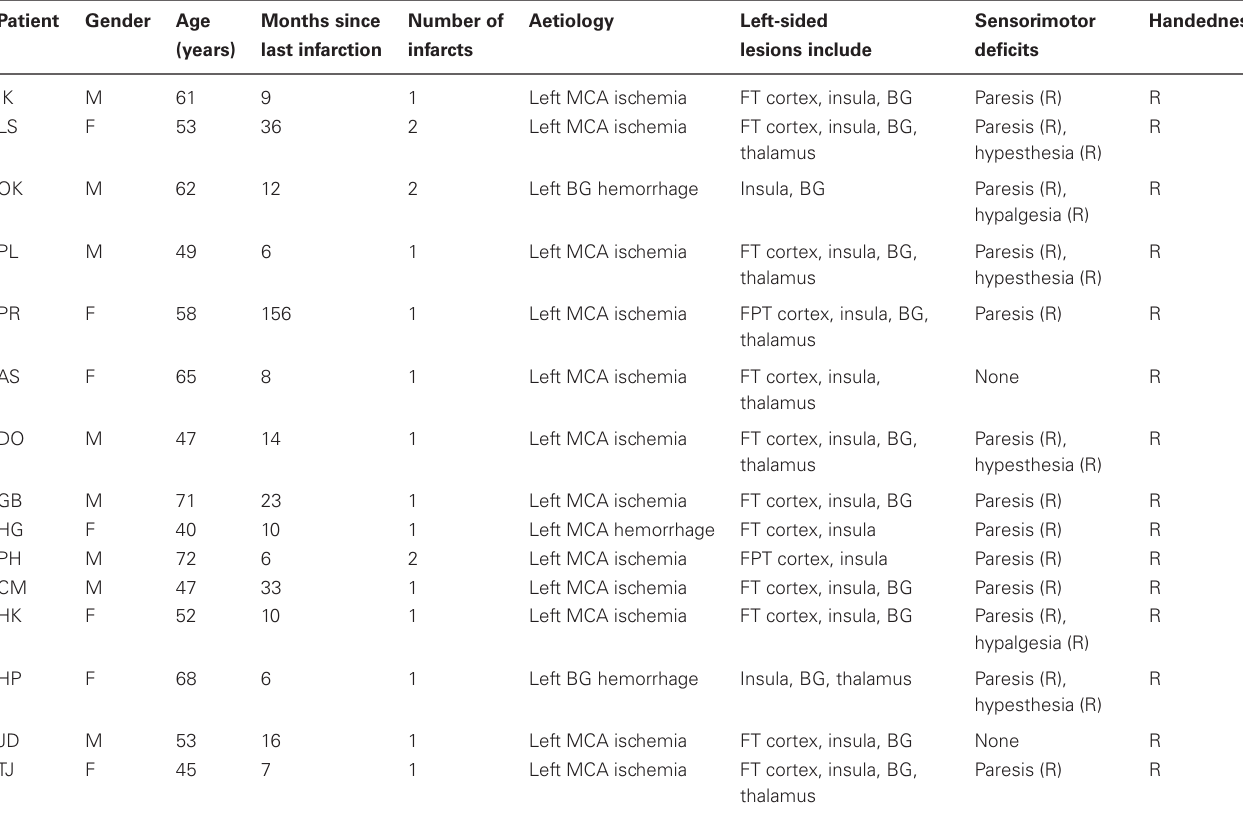
Patients are sorted by treatment group (from top to bottom ): singing therapy (patients IK, LS, OK, PL, PR), rhythmic therapy (patients AS, DO, GB, HG, PH), and standard therapy (patients CM, HK, HP, JD, TJ) .